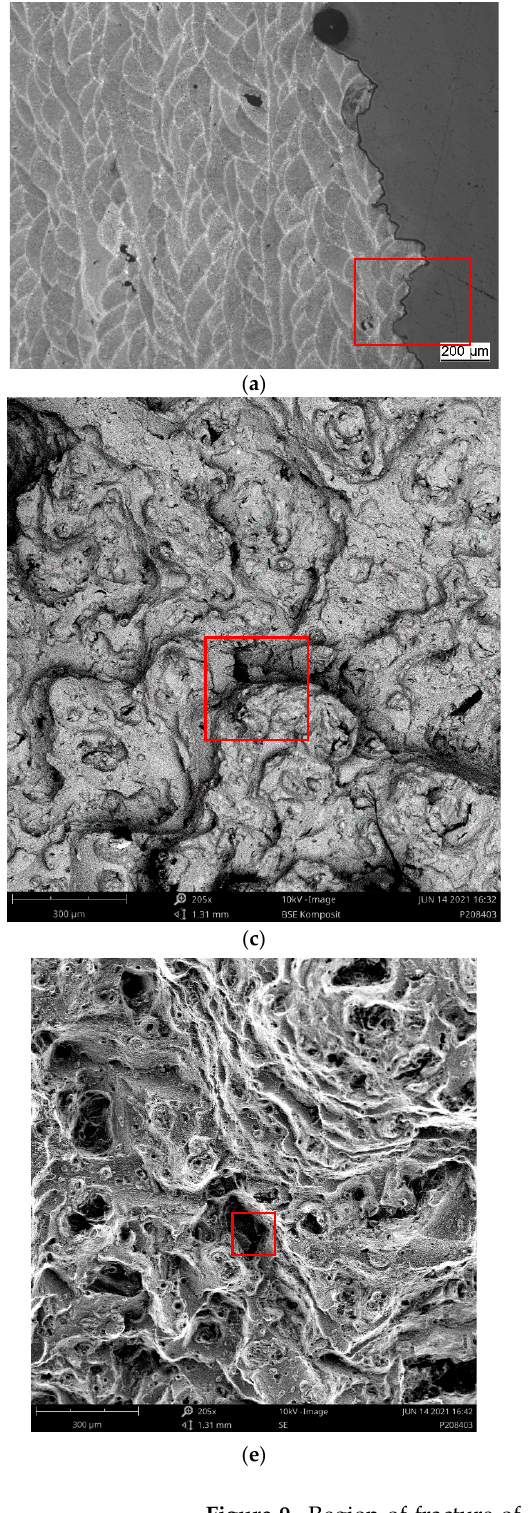
Figure 9. Region of fracture of a sample of polar angle 0 ◦ tested at 125 ◦ C: ( a , b ) metallographic section of etched samples at different magnifications, ( c , d ) back-scattered electron (BSE) images of the fracture surface at different magnifications and ( e , f ) secondary electron (SE) images of the fracture surface, overview and detailed view. Note that the red box in the image on the left highlights the area depicted in the magnified view on the